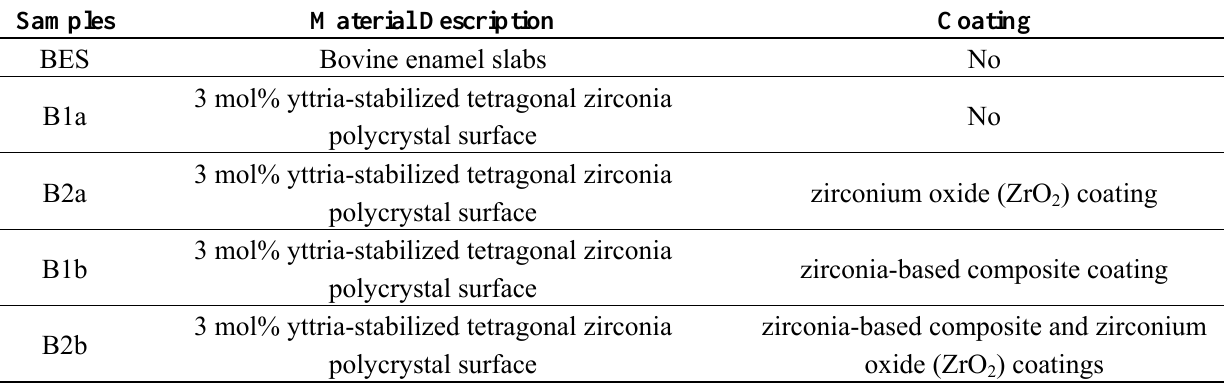
Table 1. The sample names and brief description of the tested implant material surfaces.